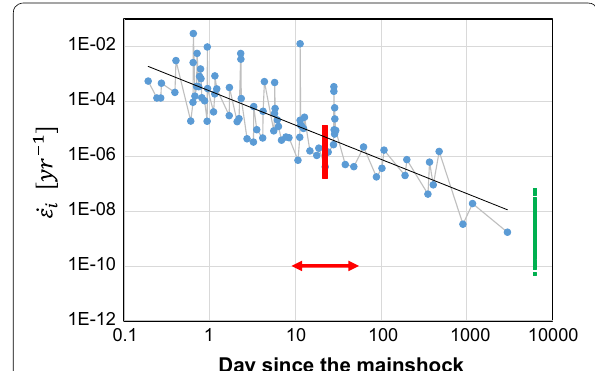
Fig. 6 Inelastic strain rate versus time elapsed since the main shock occurred. Red and green symbols indicate the estimated inelastic strain rates for the period immediately after and 18 years after the main shock, respectively. These symbols are plotted in the middle of the time-span used for calculating inelastic strain. The earlier time lapse window is indicated by a red arrow. The latter window corresponds to the width of the symbol. The blue circle indicates the average strain rate for the entire target area, estimated from the F-net moment tensor solution. The solid line is a regression line for the average rate change